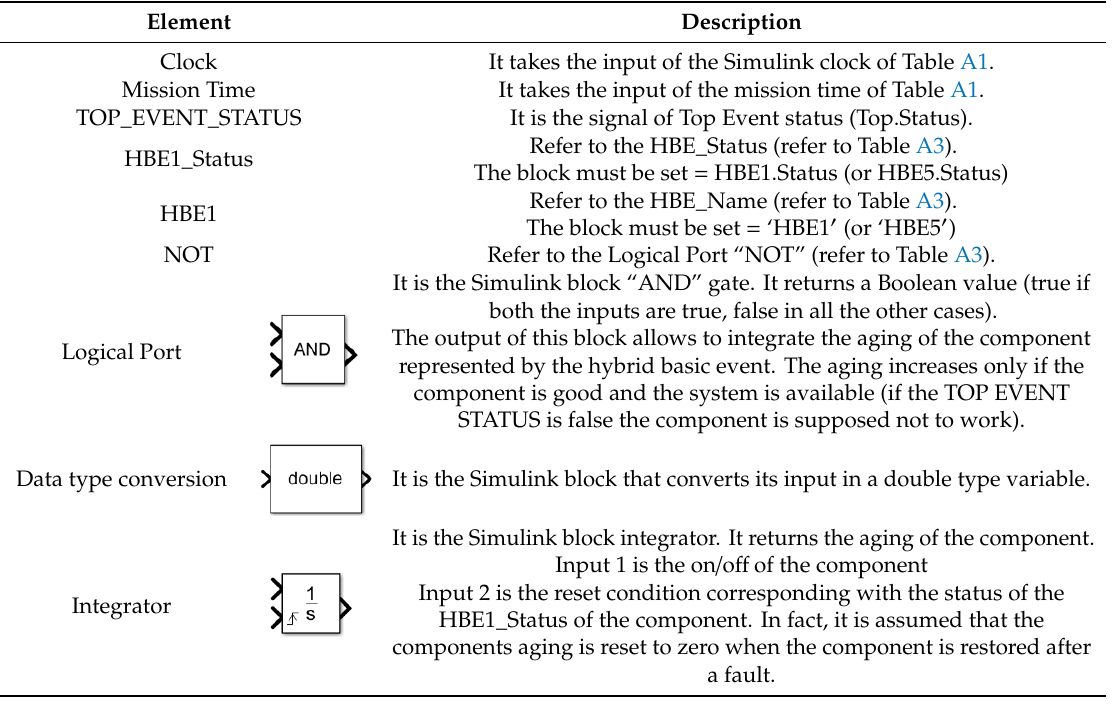
Table A7. Marking of the components of the hybrid basic events HBE1 and HBE5 (refer to Figure 4).